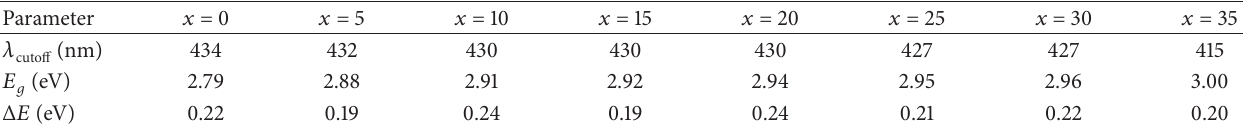
Table 1: Cut-off wavelength ( 𝜆 ), energy band gap ( 𝐸 𝑔 ), and Urbach energy ( Δ𝐸 ) of glasses of 40SiO 2 ⋅ 𝑥 ZnO ⋅ (60 − 𝑥 )Bi 2 O 3 for different cutoff values of 𝑥 .